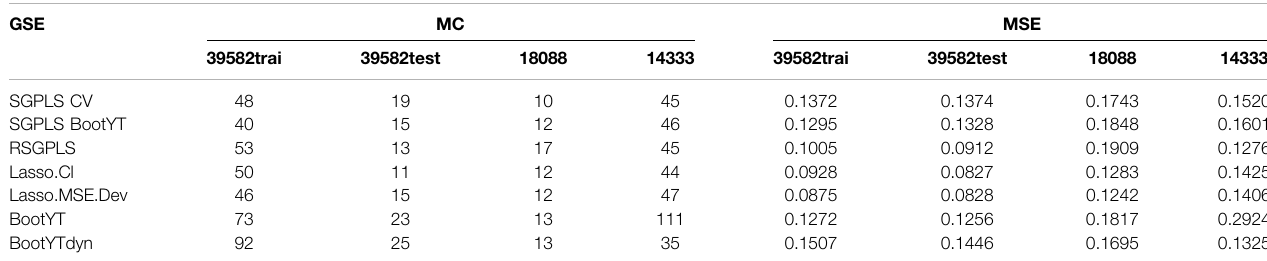
TABLE 9 | Summary of model fi tting and predictive abilities.